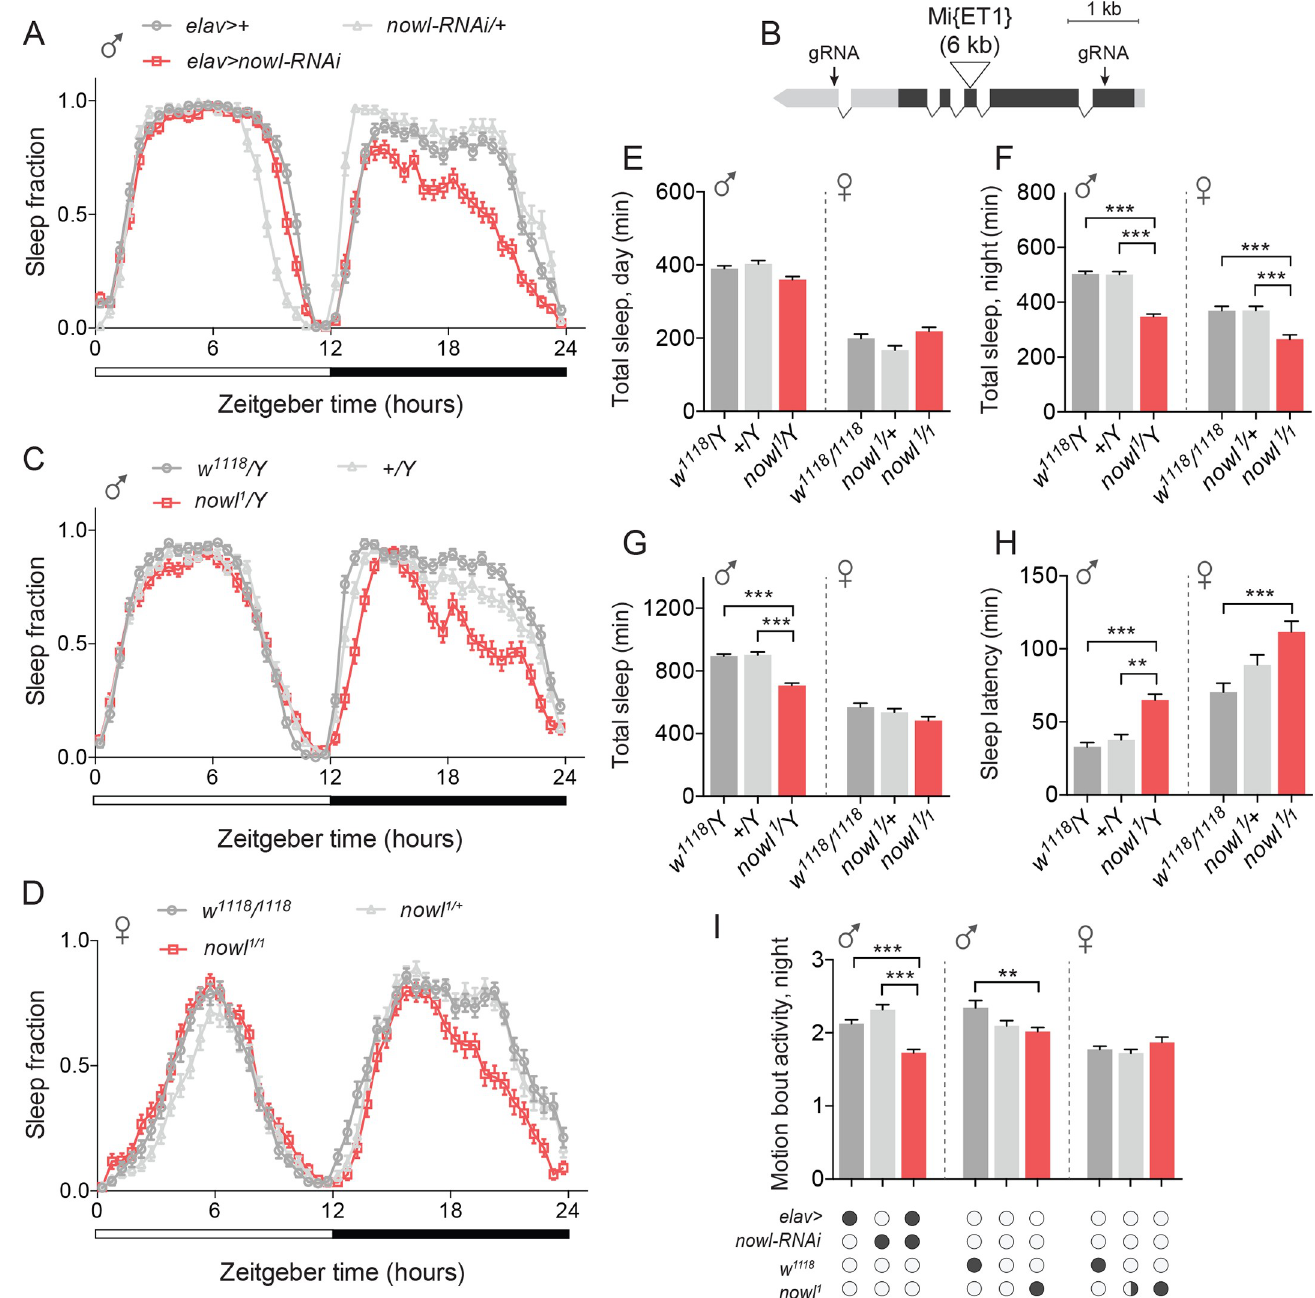
Fig 2. Neuronal loss of the LZTR1 homolog night owl ( nowl) reduces night-time sleep in Drosophila . (A) Daily sleep profiles across a 12-hour light, 12-hour dark (white and black bars) cycle for controls ( elav > + and nowl-RNAi/+ ) compared to elav > nowl-RNAi . Sleep data are binned into 30-minute intervals. (B) Schematic of the nowl locus. The gene comprises 5 0 and 3 0 untranslated regions (light grey) and a multi-exon coding region (dark grey). The locations of the 6-kb Mi{ET1} Minos transposable element inserted in the nowl 1 allele and the guide-RNA (gRNA) target sites used to induce the nowl KO CRISPR/Cas9-mediated lesion are indicated. (C, D) Sleep profiles for (C) male nowl 1 /Y and (D) female nowl 1 /nowl 1 mutant flies, compared to control genotypes [in C: w 1118 nowl + /Y ( w 1118 /Y ) and w + nowl + /Y ( +/Y ); in D: w 1118/1118 and nowl 1 /+ ]. (E-F) Total day- and night-time sleep (minutes) in male and female flies. (E) Total daytime sleep in male and female nowl 1 mutant flies. (F) Total nighttime sleep is significantly decreased in hemizygous male and homozygous female nowl 1 mutants, but not in heterozygous females. (G) Overall total sleep (min.) in male and female nowl 1 mutant flies compared to controls. Loss of nowl in male flies significantly decreases total sleep compared to controls. (H) Sleep latency measured for male and female nowl 1 mutant flies compared to controls. Loss of nowl in both male and female flies significantly increases sleep latency compared to controls. (I) Quantification of motion-bout activity (min.) during night. Motion-bout activity during the night is significantly reduced in nowl -knockdown flies. Graphs represent means with SEM (n = 32–92) of data pooled from one to three independent experiments. Significance was determined using Kruskal-Wallis test with Dunn’s post-hoc testing ( � p < 0.05, �� p < 0.01, ��� p < 0.001). https://doi.org/10.1371/journal.pgen.1008727.g002 PLOS Genetics | https://doi.org/10.1371/journal.pgen.1008727 April 27,